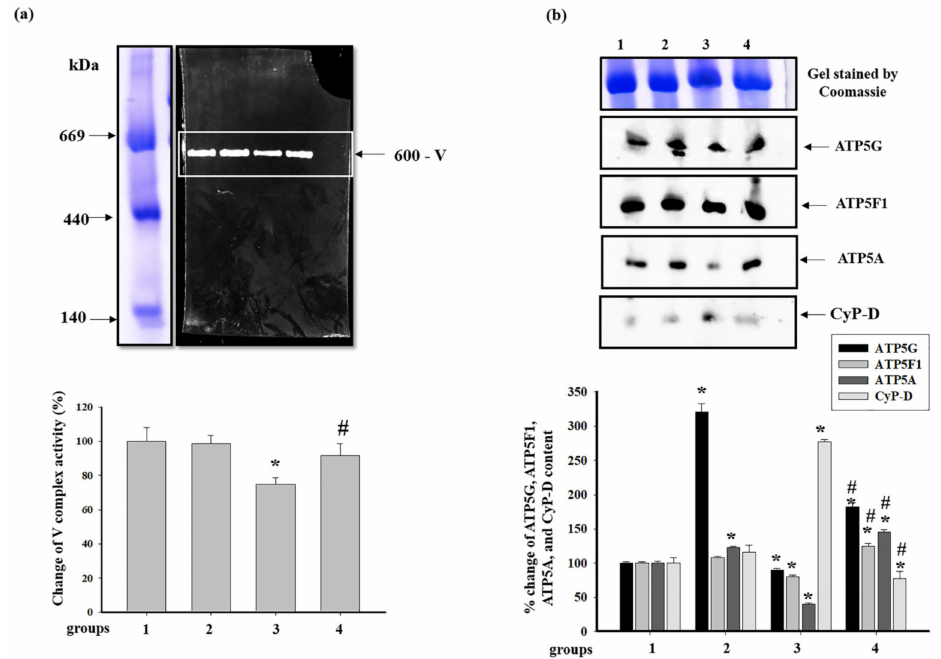
Figure 9. E ff ect of AST and ISO on the activity of ATP synthase in rat heart mitochondria. ( a ) The upper part: freshly prepared rat mitochondria isolated from each group were solubilized in the bu ff er for BNE samples (Materials and Methods section). Mitochondrial samples were separated by 1D BNE, and the gel was stained for 16 h for the detection of complex V (CV) activity by a bu ff er containing 10 mM ATP, 35 mM Tris (HCL), 270 mM glycine, 14 mM MgSO 4 , and 0.2% Pb(NO 3 ) 2 ; the lower part: a diagram quantitatively reflecting changes in CV activity; ( b ) the upper part: excised bands with enzymatic activity were subjected to 2D SDS-PAGE and blotted onto nitrocellulose for immunodetection using monoclonal antibodies against subunits α (ATP5A), c (ATP5G), b (ATP5F1), and CyP-D; the lower part: a diagram quantitatively reflecting changes in the protein levels. The data are presented as the means ± SDs of four independent experiments. * p < 0.05—significant di ff erence in the protein level compared with the control (group 1), # p < 0.05 compared to RHM from ISO-injected rats (group 3). The statistical significance of the di ff erences between the pairs of mean values was evaluated using the Student-Newman-Keul test (Supplementary Materials, p.